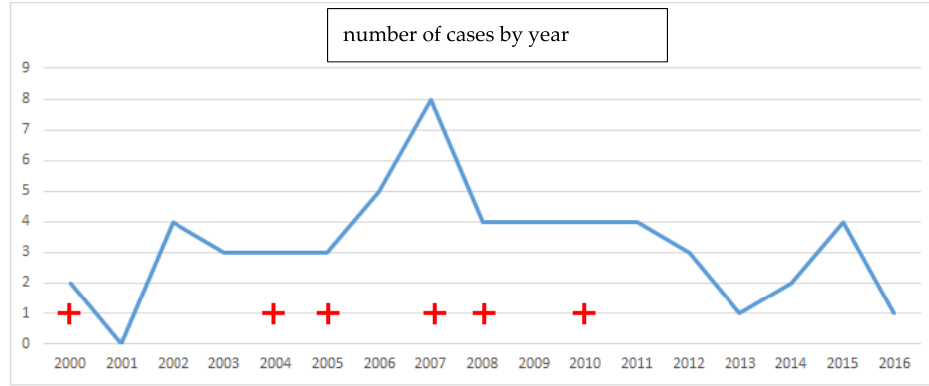
Figure 1. Prevalence curve of deaths (red cross) and cases of acute Rubigine ® poisoning in Martinique.